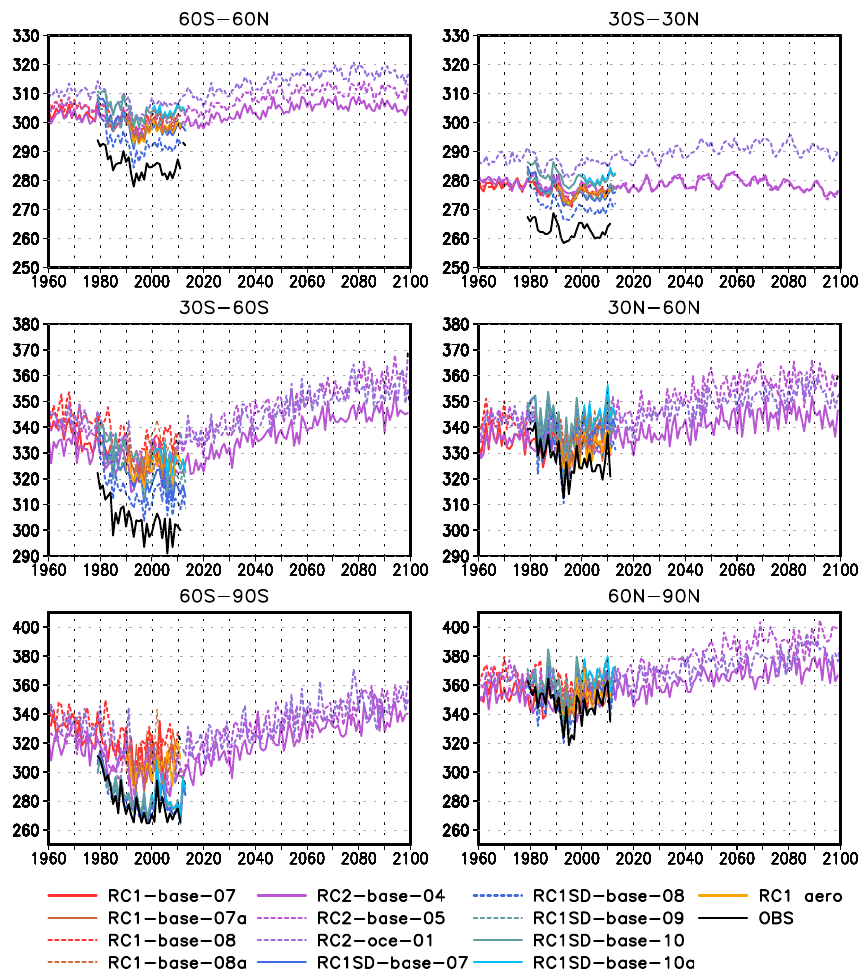
Figure 28. Time series of annual mean total column ozone (in DU) averaged over different latitude bands. BSTCO observations are shown in black. Note the different scales for the different